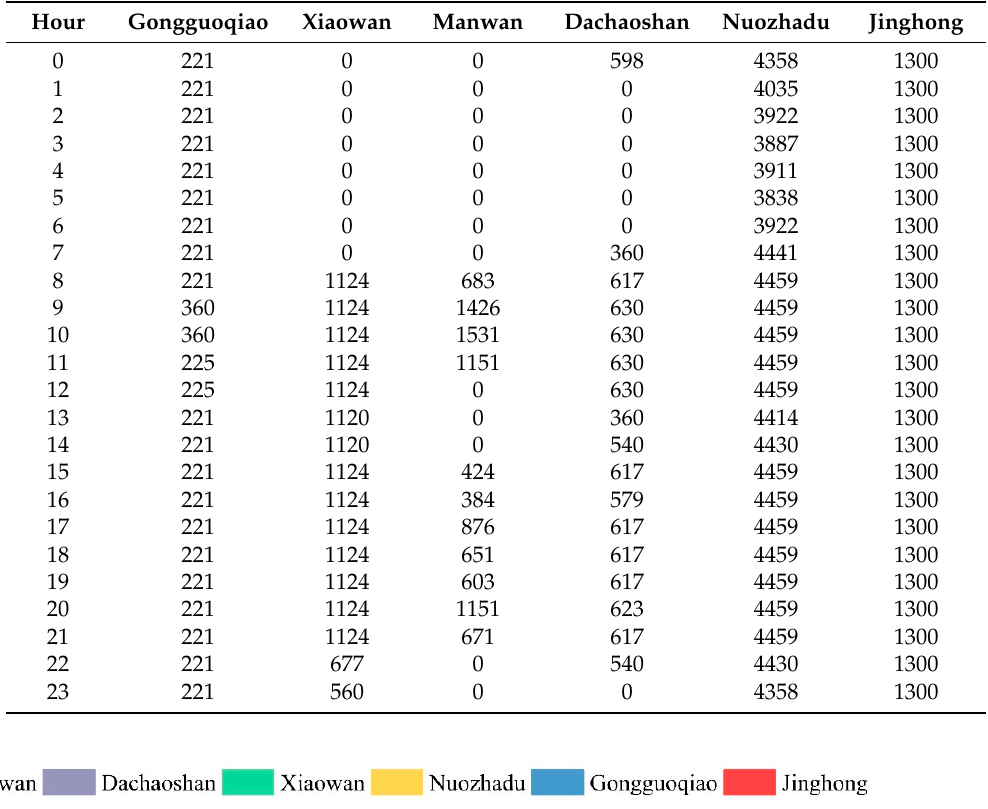
Table 3. Hourly power generations of plants.